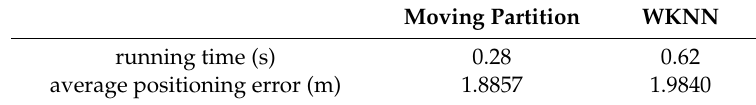
Table 3. Performance comparison of “moving partition” and Weighted K-Nearest Neighbors (WKNN).